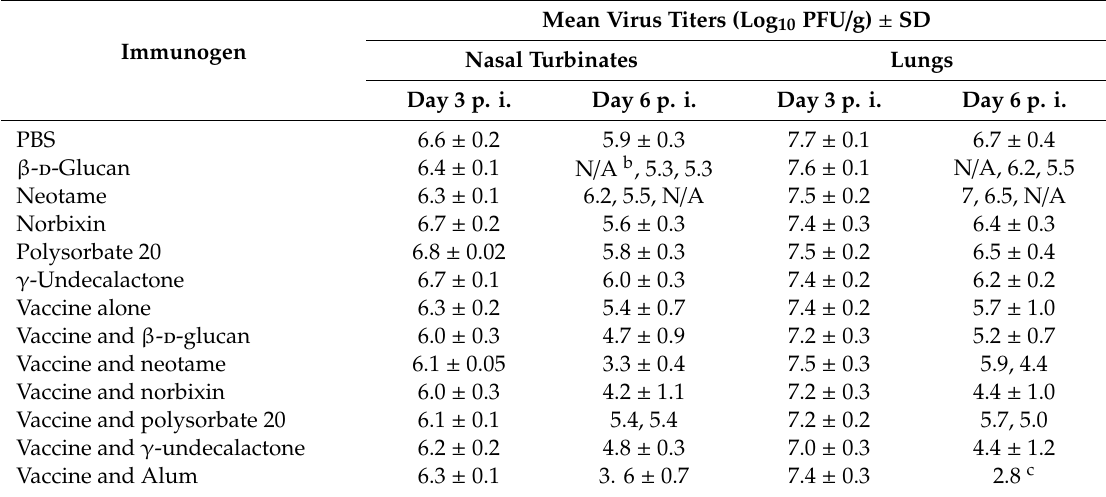
Table 3. Virus titers in the respiratory tract of immunized mice after challenge a